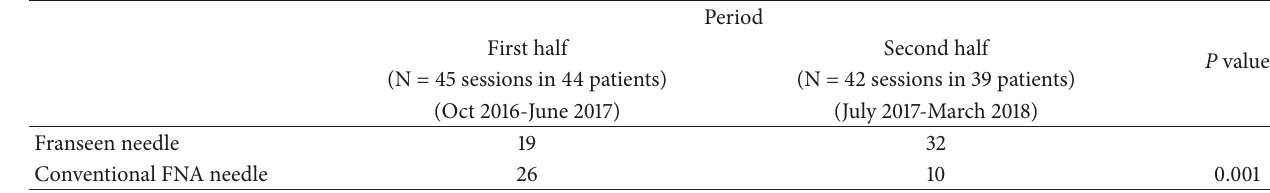
Table 3: Needles used according to the study